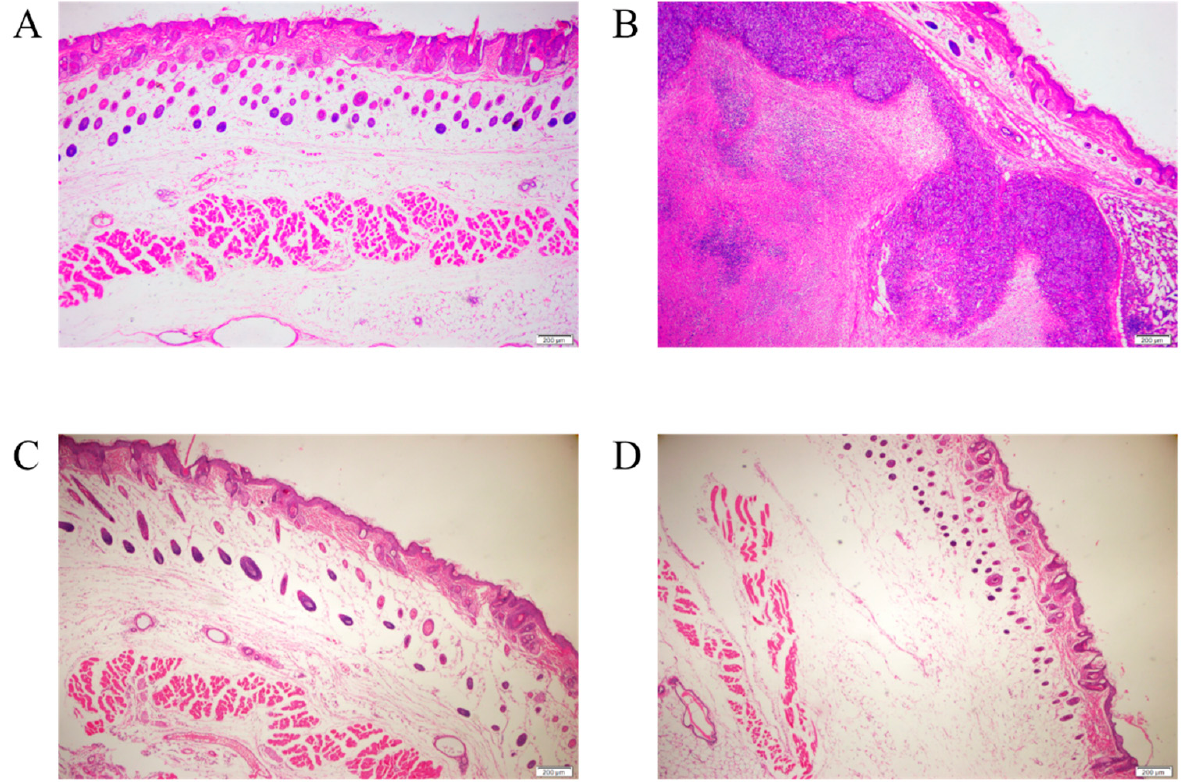
Figure 4. Hematoxylin and eosin stains of the skin tissue from the injection sites of athymus mice. The histological sections (4 × ) of axillary skin in group 1 injected with suspension MDBK cells ( A ), group 2 injected with Hela cells ( B ), group 3 injected with ST cells ( C ) and group 4 injected with ST503 medium ( D ) were observed by microscope. The scale bar (200 µ m) is shown in the lower right corner of the picture.